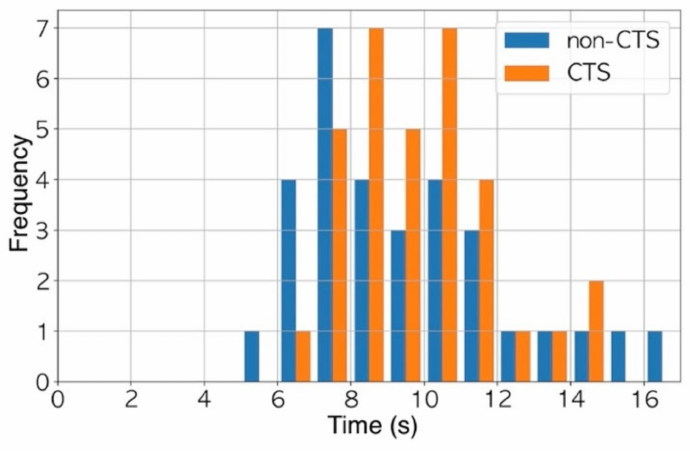
Figure 3. All participants took at least 5 s to complete the